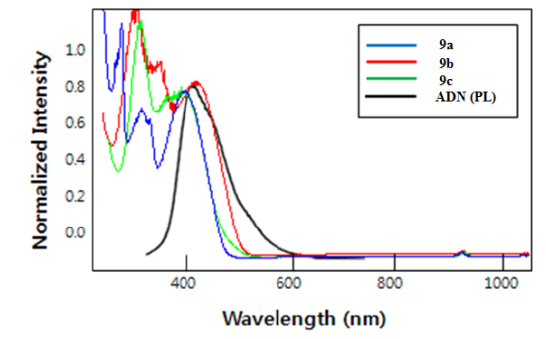
Figure 2. UV spectra of green dopants 9